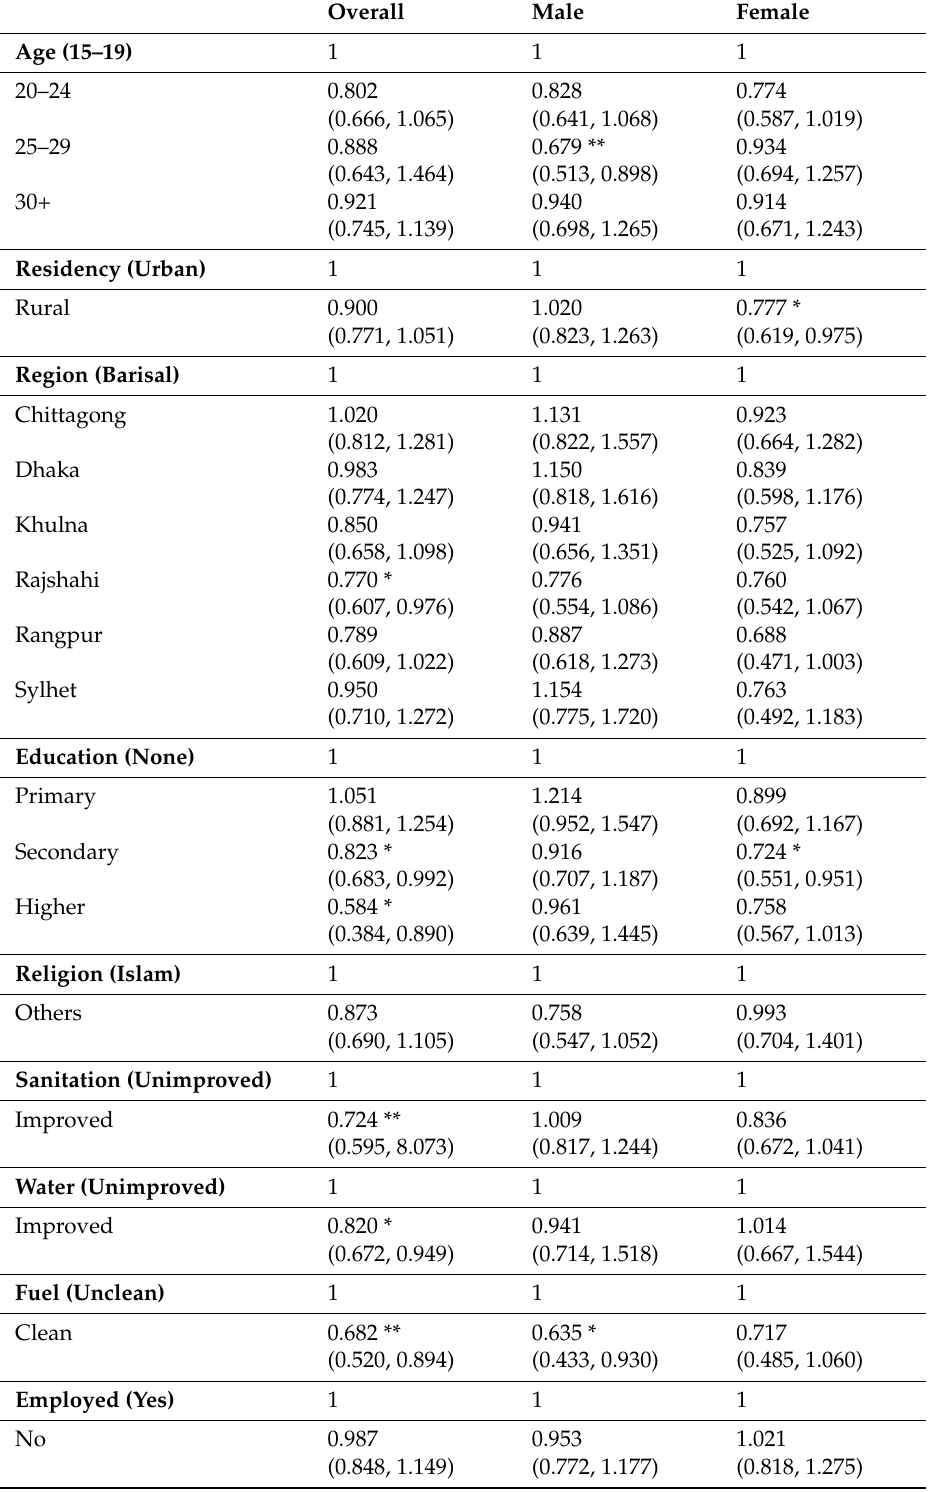
Table 2. Predictors of dyspnea among under-five children in Bangladesh. Bangladesh Demographic and Health Survey